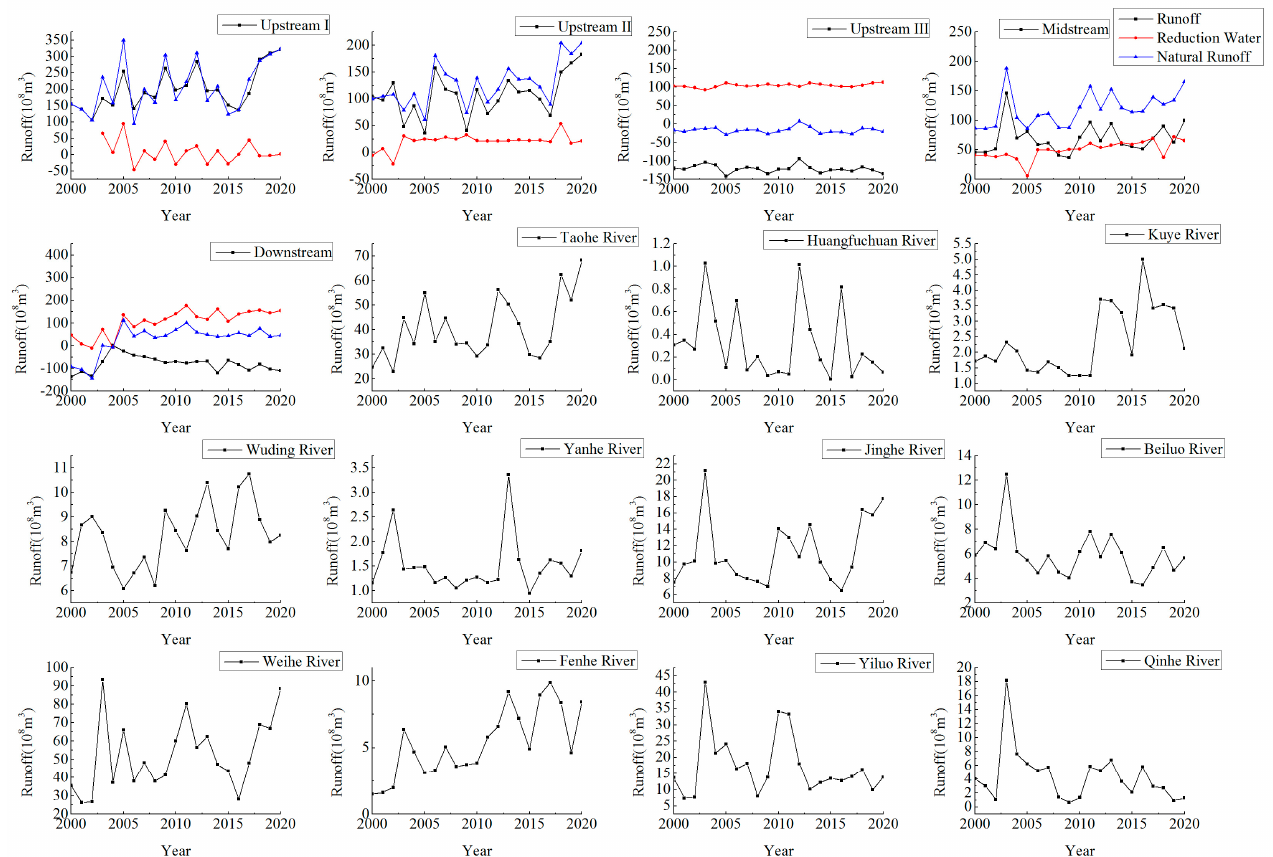
Figure 5. Dynamic changes in the runoff, reductive runoff, and natural runoff in the Yellow River basin; this figure includes the change in runoff in each division of the main stream and tributaries.